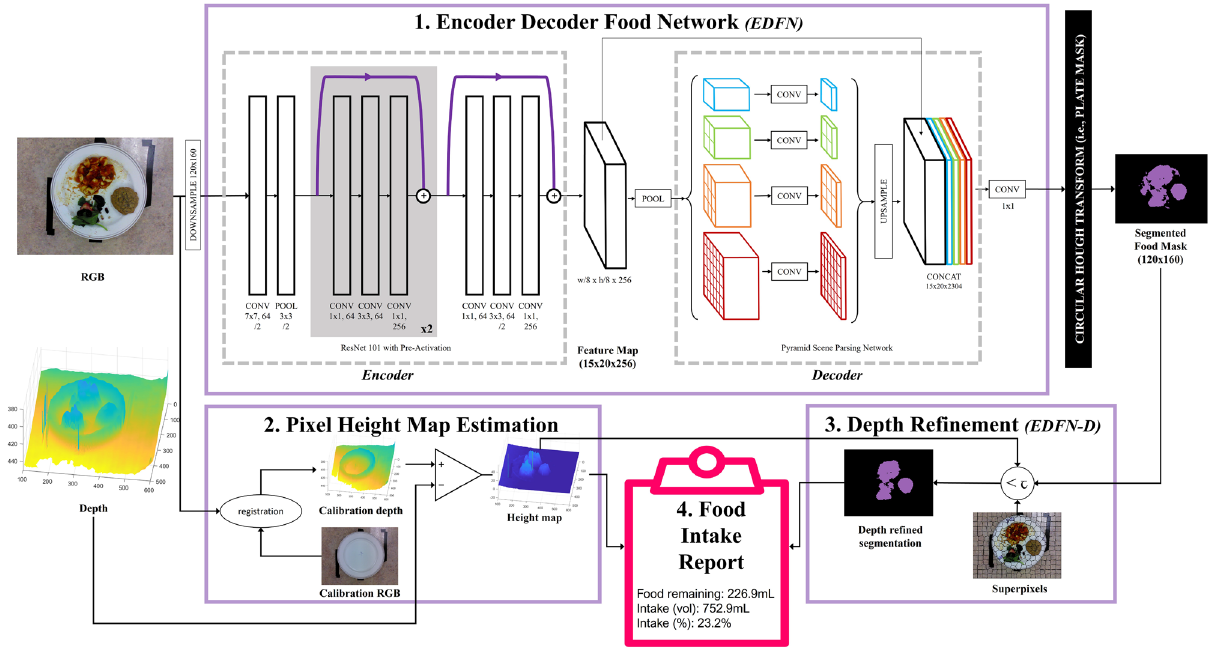
Figure 1. System diagram of the proposed deep food segmentation network comprised of: (1) encoder-decoder food network (EDFN) consisting of a residual encoder microarchitecture 60 and a pyramid scene parsing 61 decoder microarchitecture which outputs a segmented food mask; (2) pixel height map estimation for assessing food depth; (3) depth refinement which outputs a depth-refined food mask (EDFN-D); and (4) food intake report summarizing the volume of food on the plate, the intake amount (in mL) and the intake percent.Our network was tested on a custom dataset of foods offered in long-term care representing both regular texture and modified texture foods (e.g.,